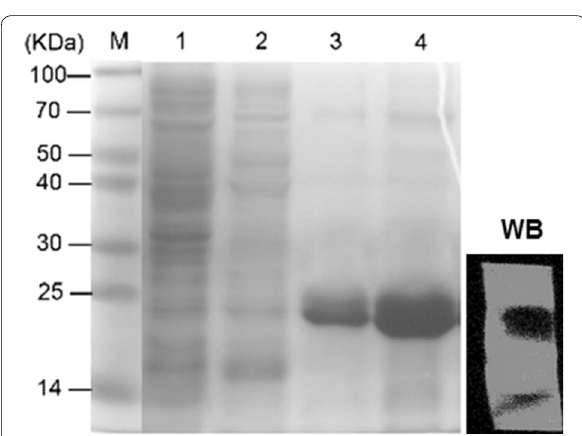
Fig. 4 Expression and purification of the S7 antibody. The gene fragment of the S7 antibody was ligated into a modified pET-25b vector and fusion expression with SBP Tag. The recombinant S7 antibody was purified with Ni–NTA agarose and verified with HRP-streptavidin in western blot analysis. Lane M, molecular weight marker. Lane 1, the supernatant of E. coli cell lysate that were transformed with the S7 antibody gene after induction. Lane 2, the flow-through from Ni–NTA Agarose after incubation with the S7 antibody. Lane 3, elution 1. Lane 4, elution 2. Lane WB, western blot analysis of the purified S7